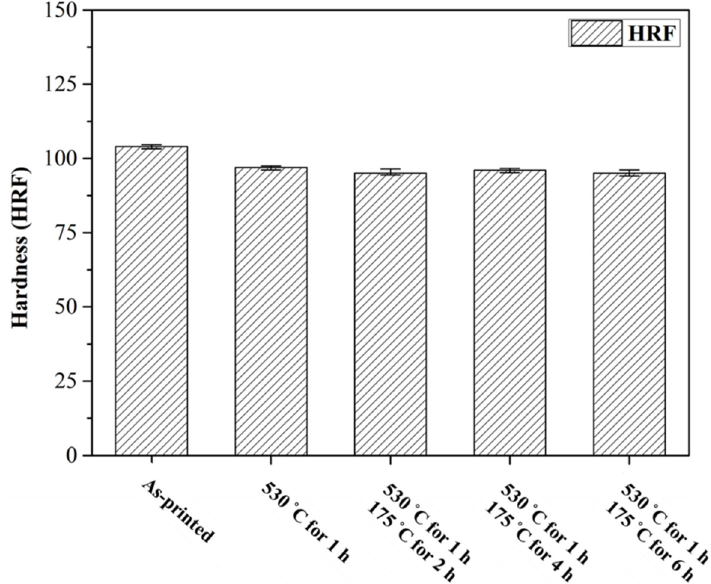
Figure 5. Hardness of the Al-Ni-Cu alloy before and after solution treatment.